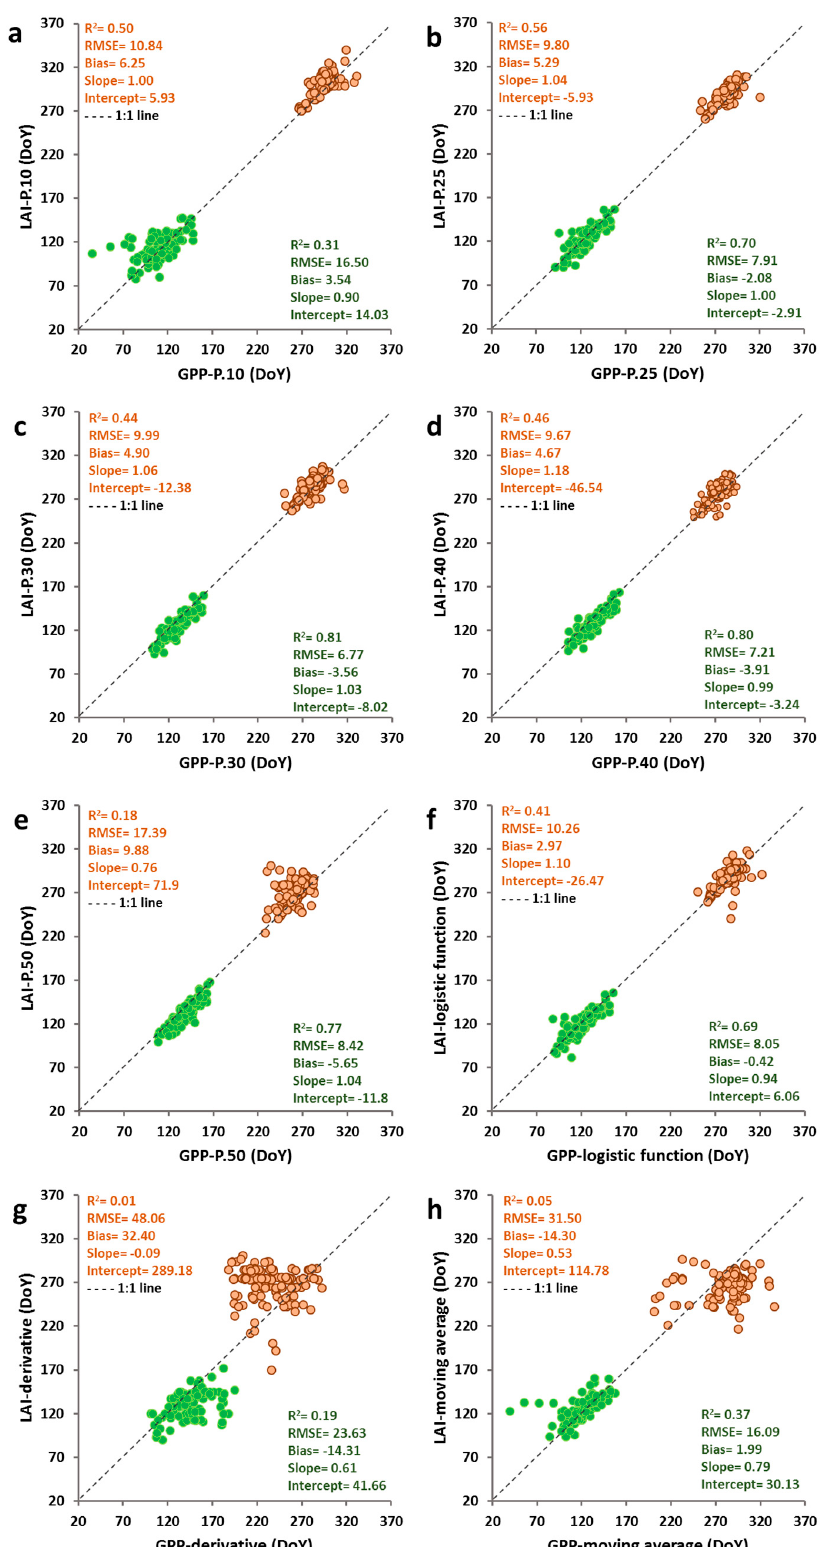
Figure 5. Scatterplots for SoS (in green) and EoS (in orange) estimated from CGLS LAI V2 and FLUXNET GPP time series by the threshold (10th ( a ), 25th ( b ), 30th ( c ), 40th ( d ) and 50th ( e ) percentiles of LAI amplitude, logistic-function ( f ), derivative ( g ) and moving-average ( h ) methods. Statistics of the comparison are presented in Table 2.